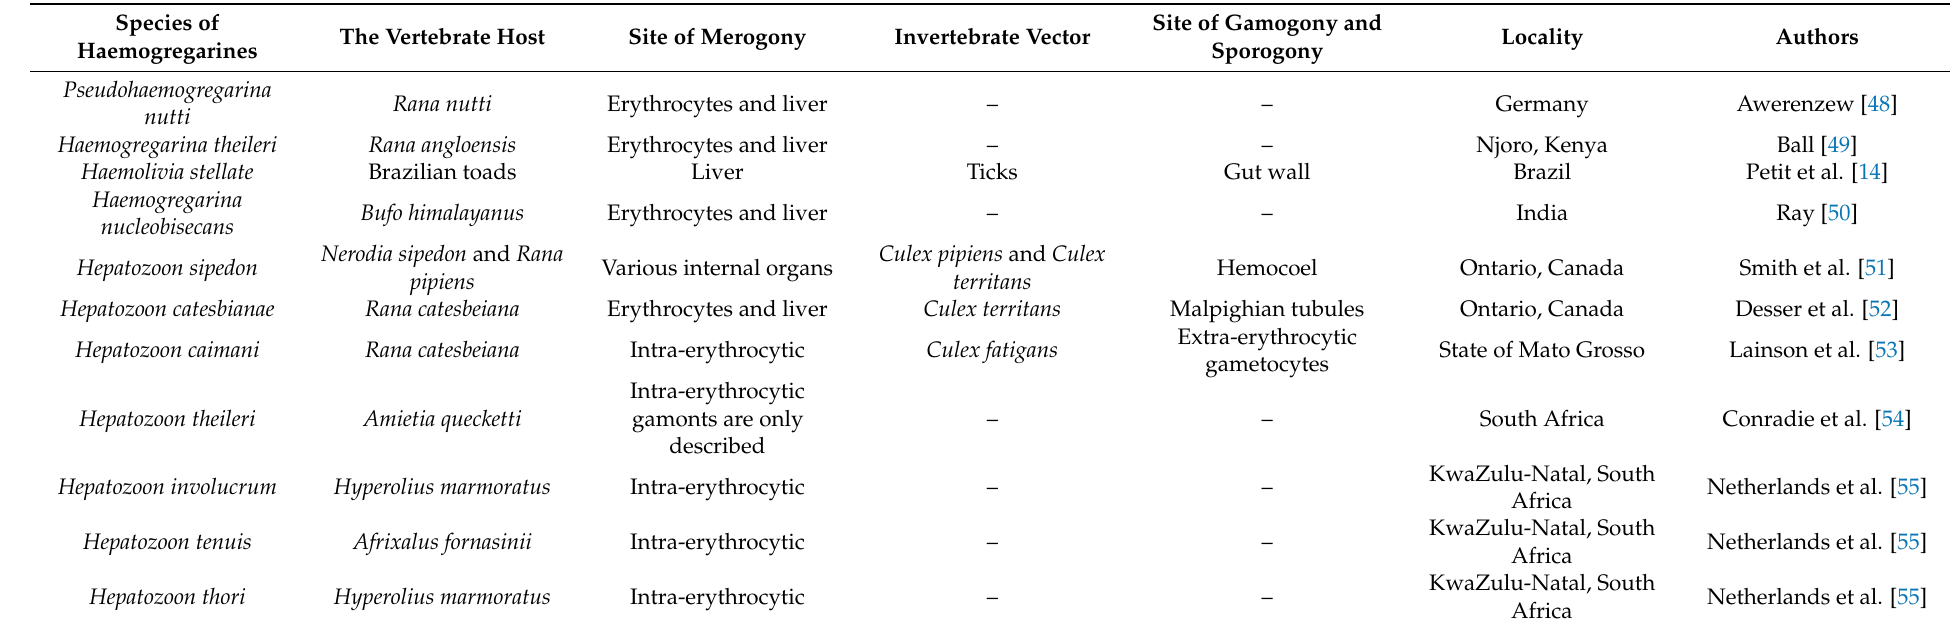
Table 3. Haemogregarines of